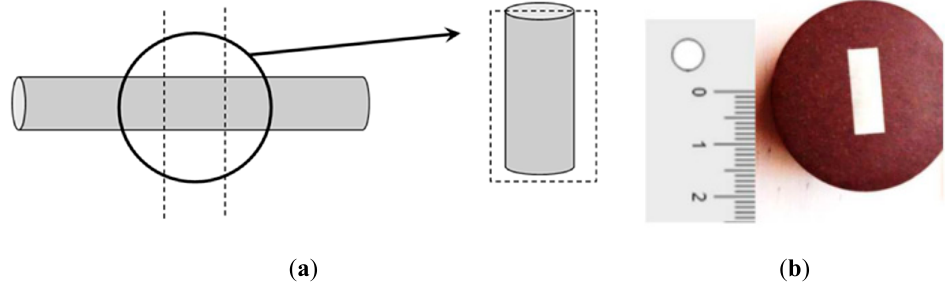
Figure 2. Preparation of pearlitic steel samples: ( a ) longitudinal cutting, ( b ) mounted in resin.